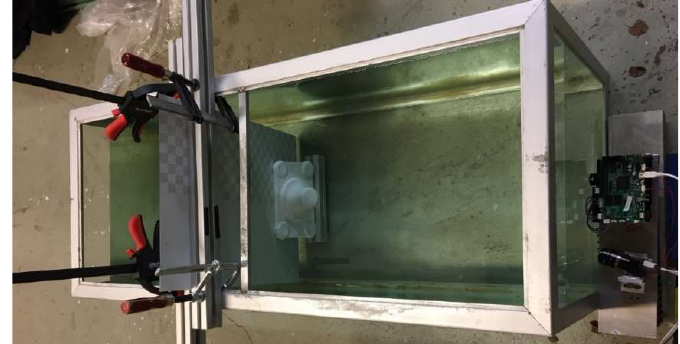
Figure 6. Test setup. The camera is placed on the right outside the aquarium of dimensions (125 cm × 50 cm × 50 cm).